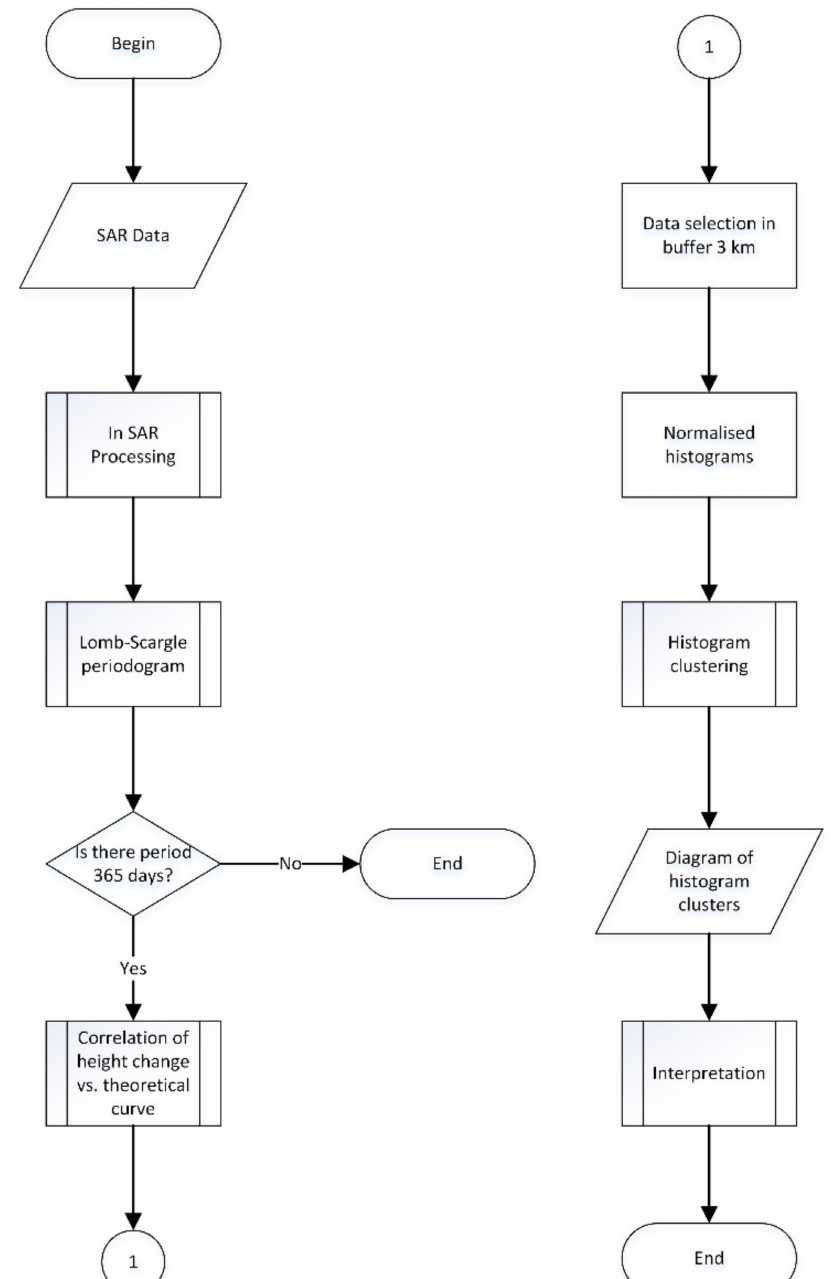
Figure 5. Processing workflow